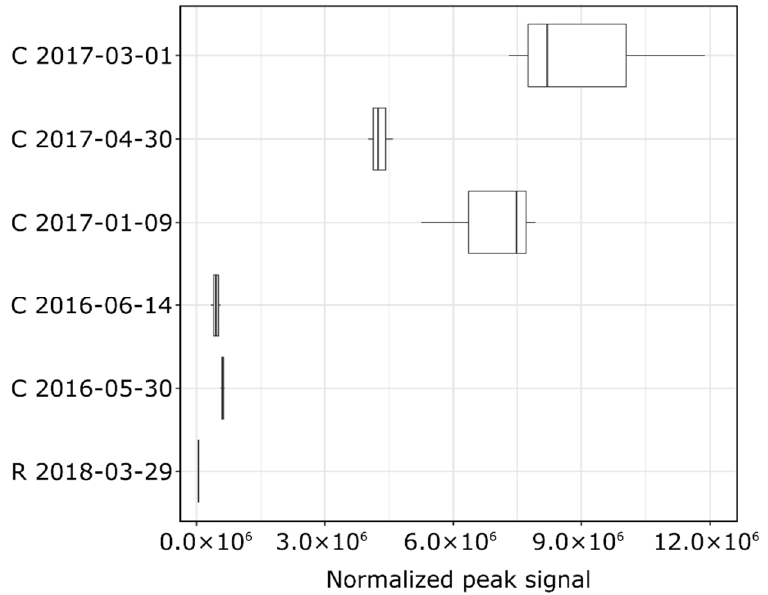
Figure 6. Boxplots representing the intensities of 1,3-diphenylguanidine in each sample (triplicate injections), normalized by the intensity of propylparaben-d4 injected as internal standard. C = Compans site; R = Rosny site.